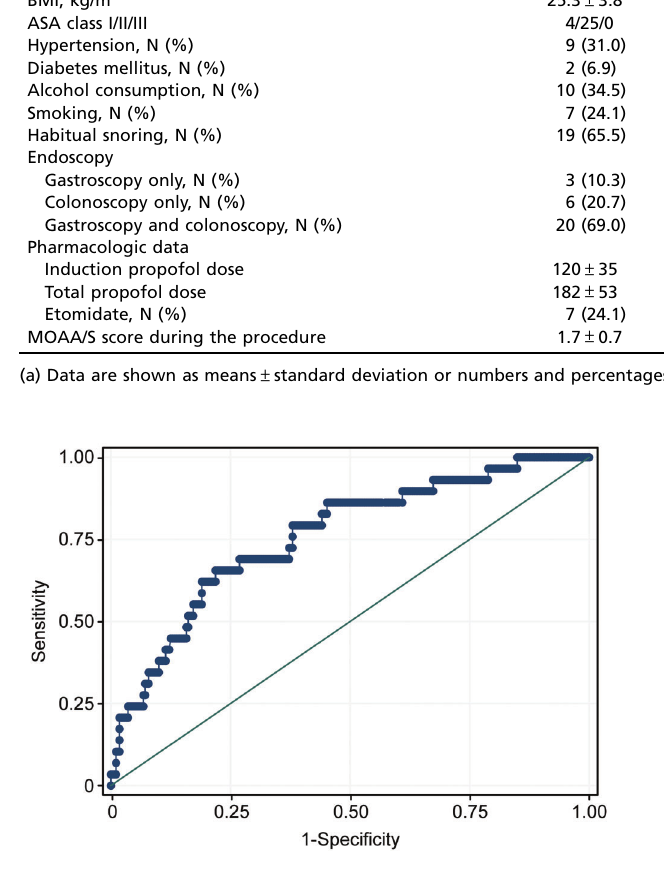
Figure 1 - ROC curve for the implemented LR model to predict hypoxemia. The AUC for the LR model developed for the predic- tion of hypoxemia was 0.76 ± 0.05. The ideal AUC was 1.00. The reference line represents an AUC of 0.50, which is based on chance alone.